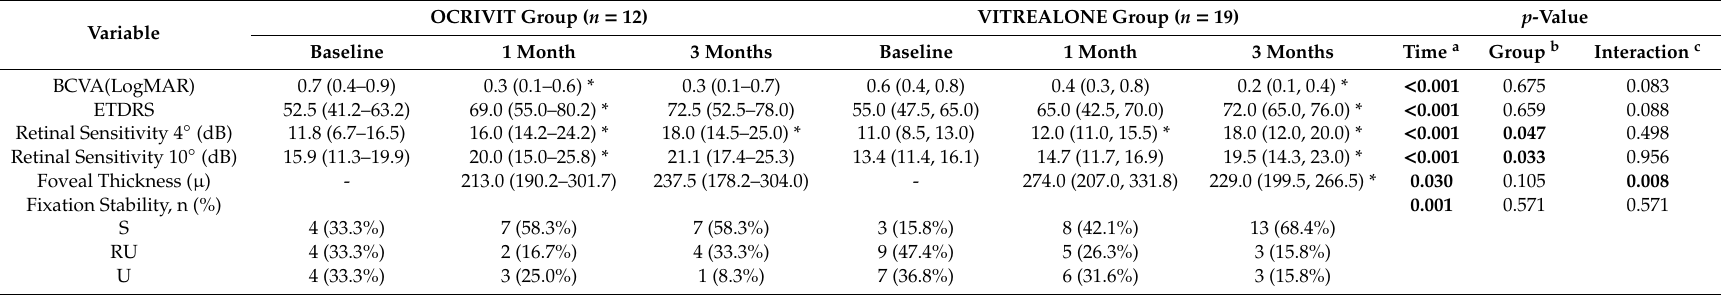
Table 3. Functional and structural findings before and after surgery in the OCRIVIT group vs. VITREALONE